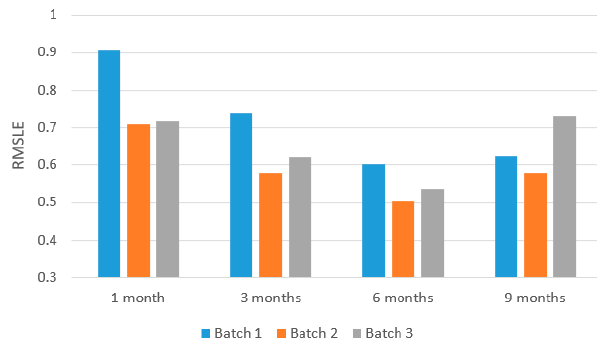
Figure 12. Different periods of prediction for Rental.